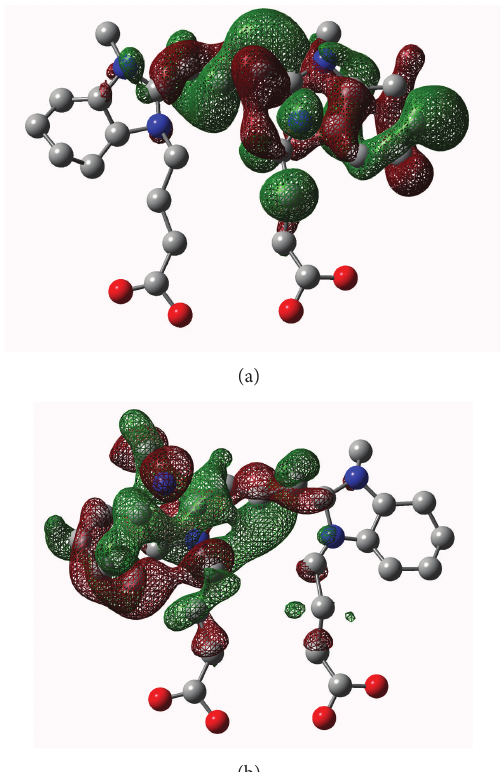
Figure 4: The (a) contour surface of HOMO and (b) presents contour surface of LUMO. Shown are the contour isosurfaces of orbital amplitude 0.02 (red) and − 0.02